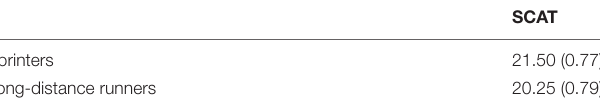
TABLE 1 | SCAT scores (scores, SEM) in each